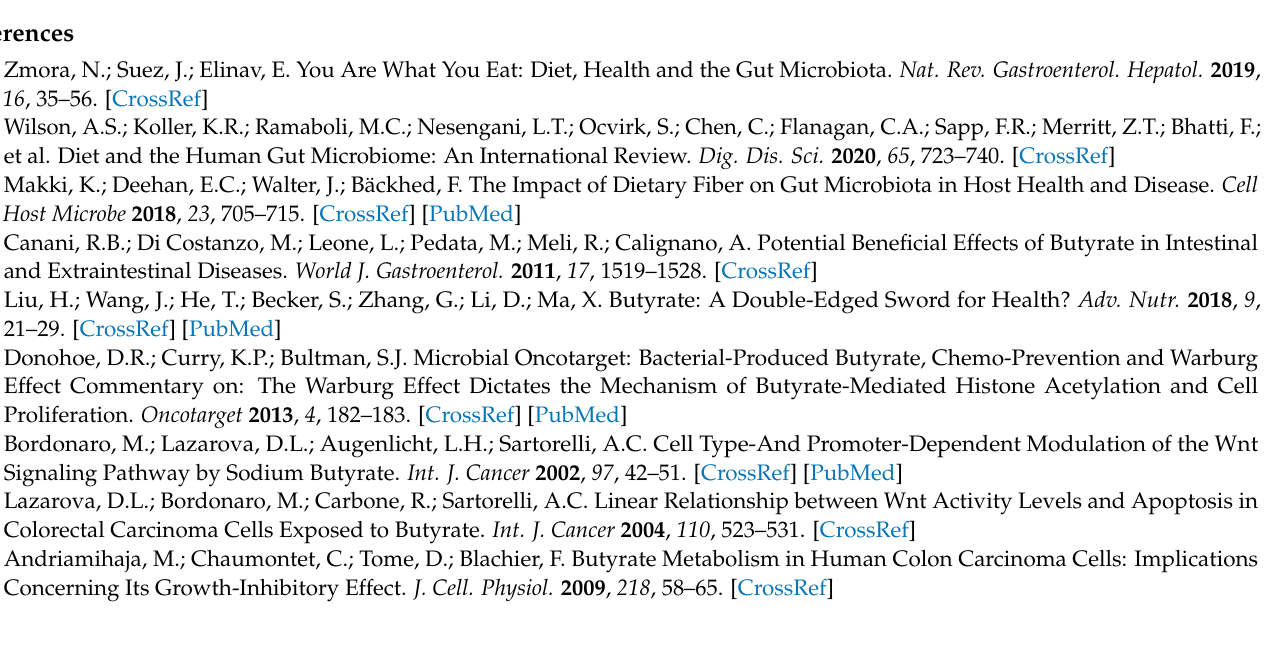
pro-caspase 3, Table S1: List of the authentic standards used for HPLC-MS analysis of the phytate preparation, Table S2: Primers used in the